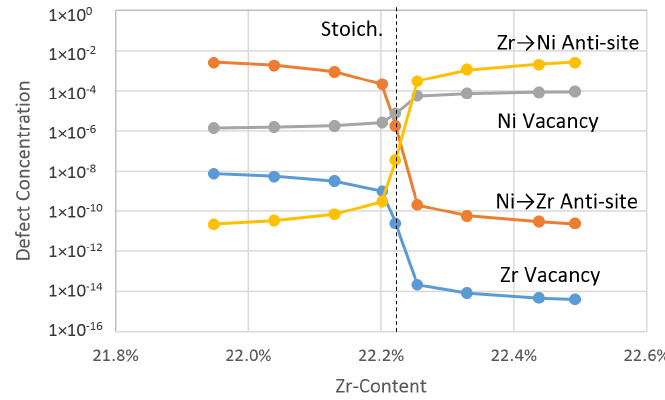
Figure 5. Theoretical defect concentrations for Zr 2 Ni 7 at 1000 °C.